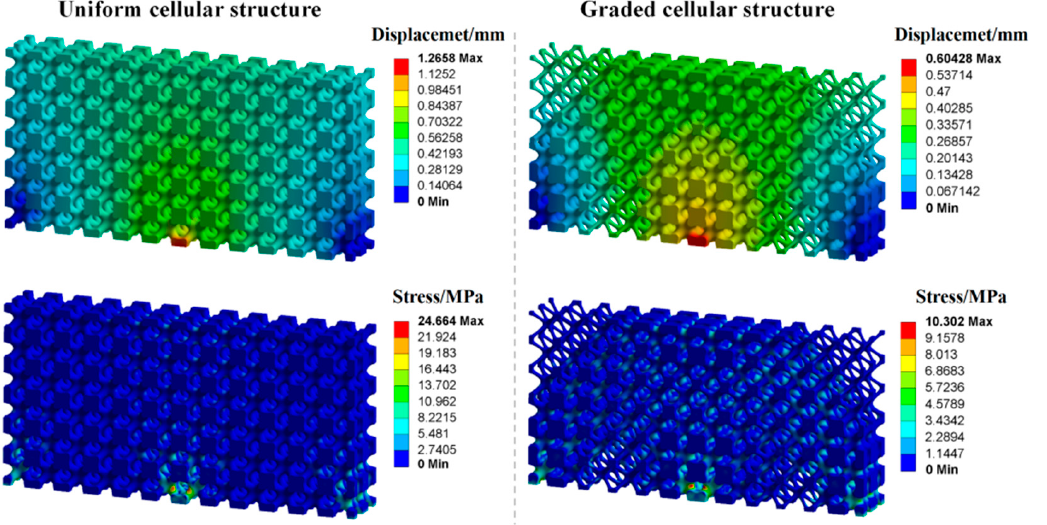
Figure 16. Deformation and stress nephograms of uniform cellular structure and optimized FGCS.